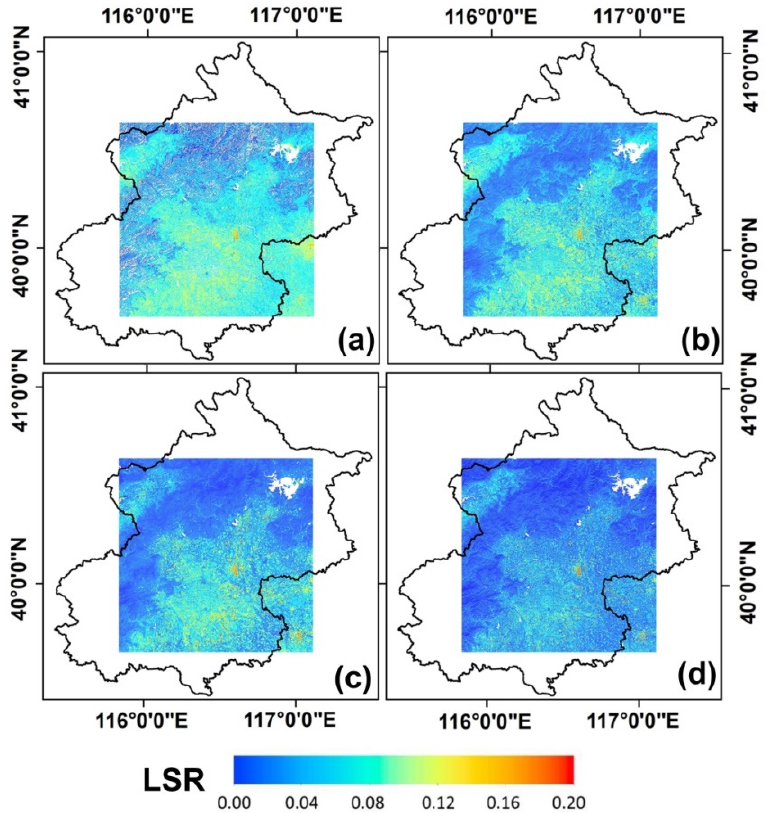
Figure A1. Polar plot illustrating the solar and view geometry of Landsat-8 (red) and Sentinel-2 (blue) data in the study period. The radial straight lines show azimuth spaced every 30° and the circles show zenith spaced every 20°.